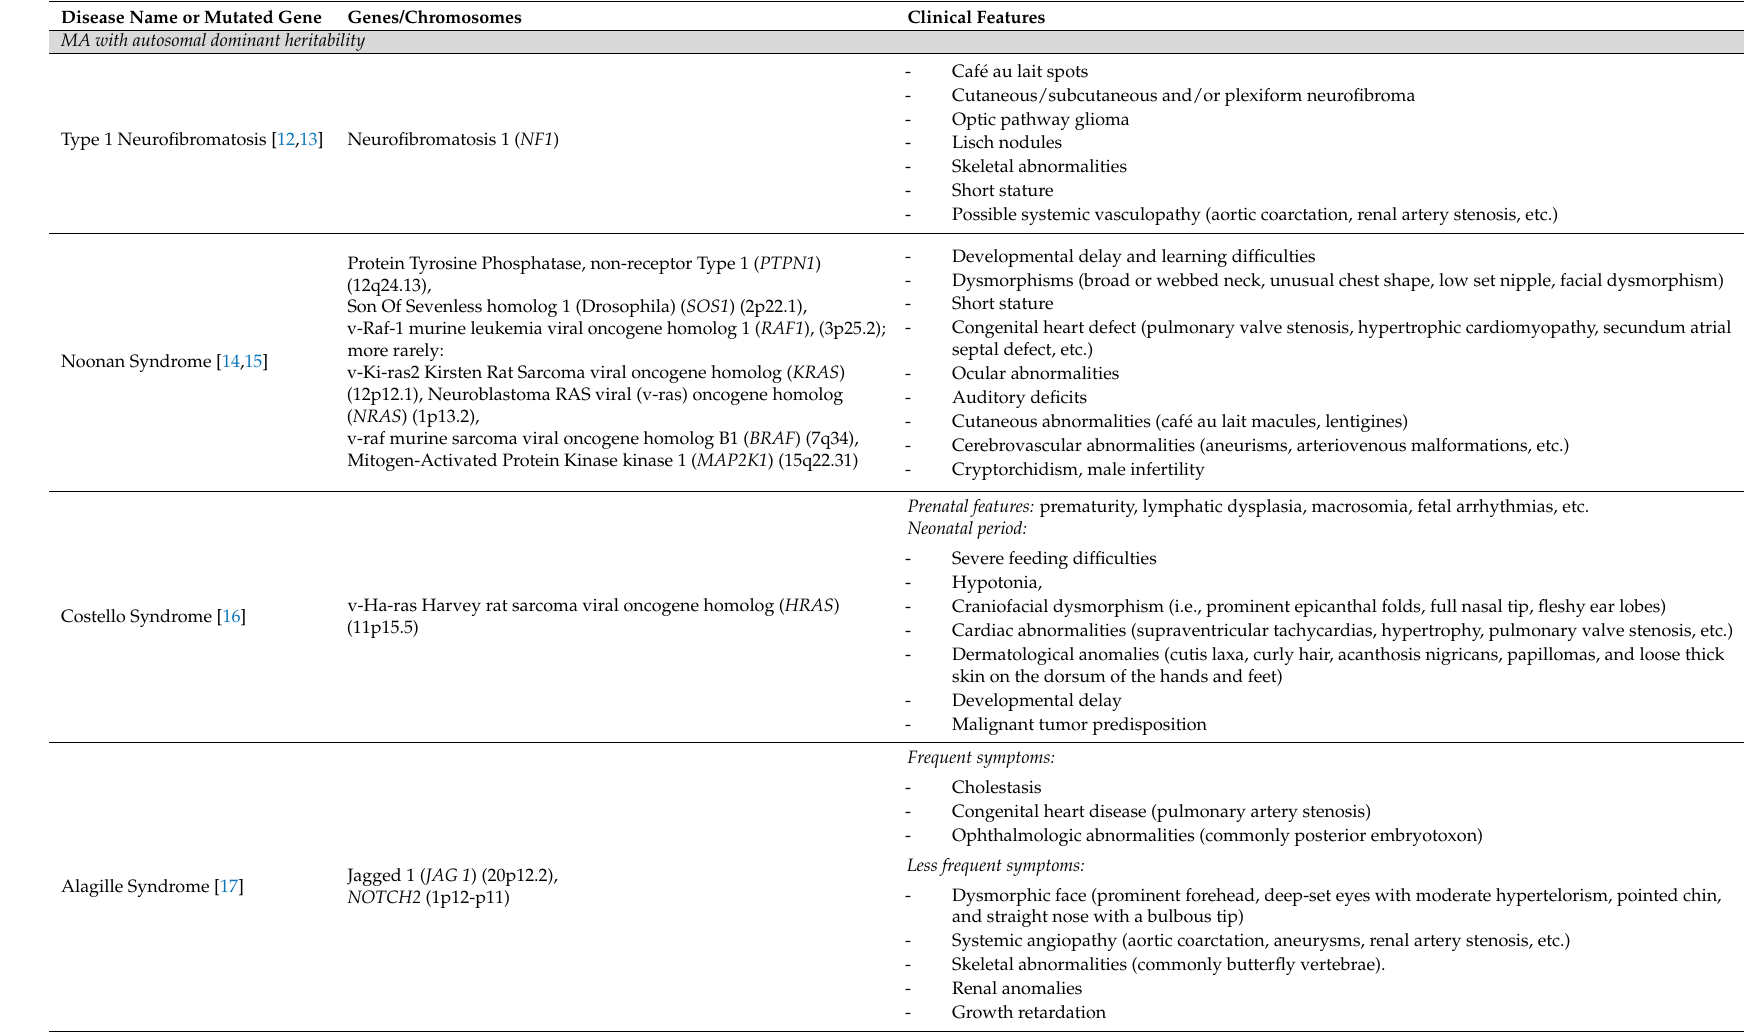
Table 1. Sporadic syndromic cases of moyamoya angiopathy